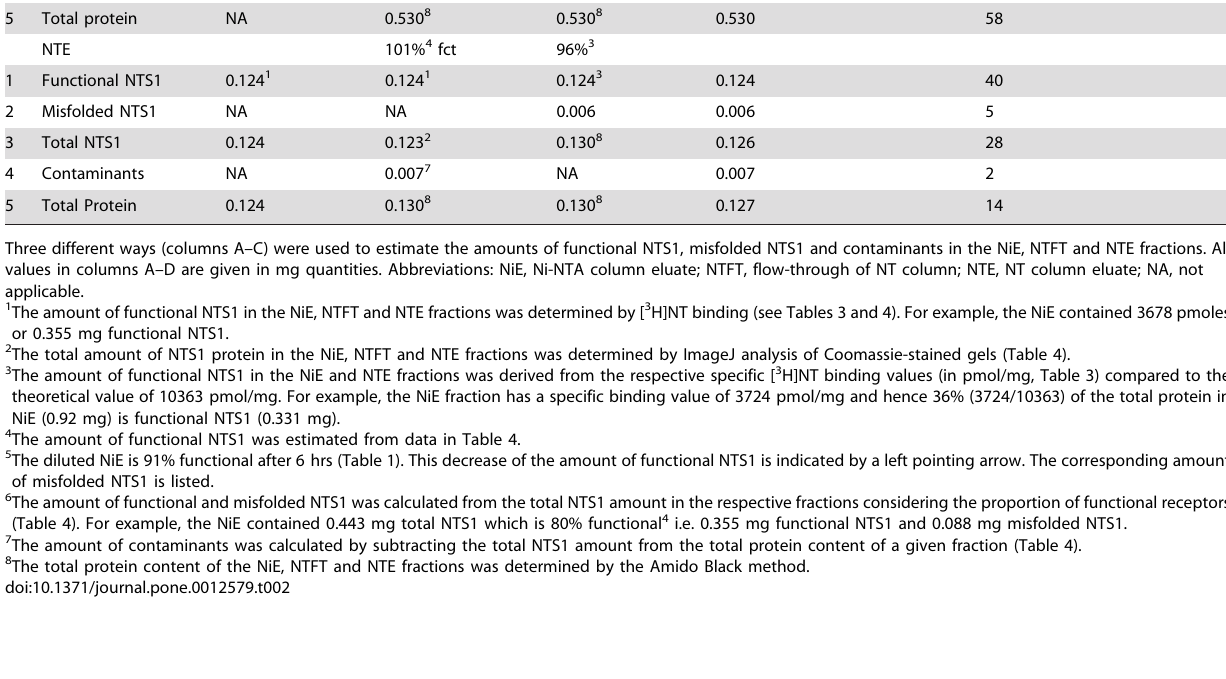
By Image J analysis of gels